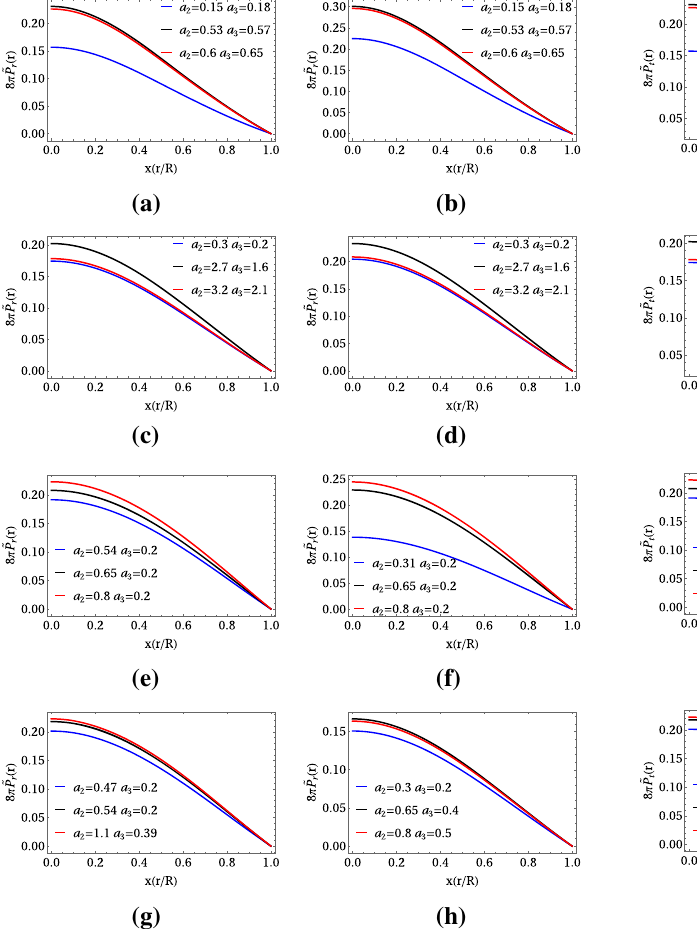
Fig. 4 ˜ P r ( r ) as a function of r for Model 1: ( a ) u = 0.19803, ( b ) u = 0.2035, Model 2: ( c ) u = 0.19803, ( d ) u = 0.2035, Model 3: ( e ) u = 0.19803, ( f ) u = 0.2035, Model 4: ( g ) u = 0.19803, ( h ) u = 0.2035